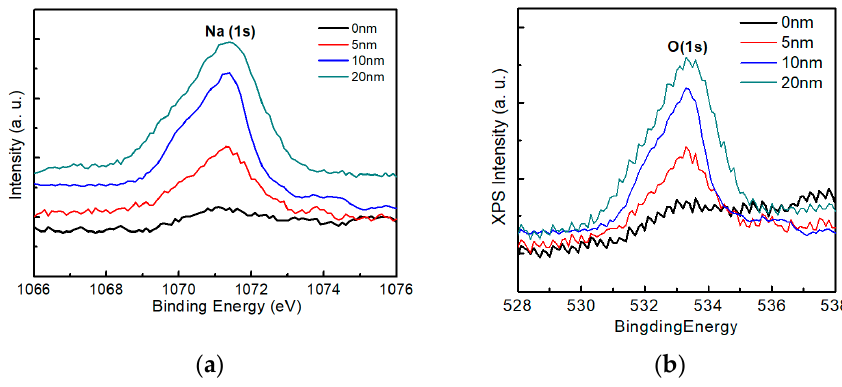
Figure 12. X-ray photoelectron spectroscopy measurements of samples containing various sodium